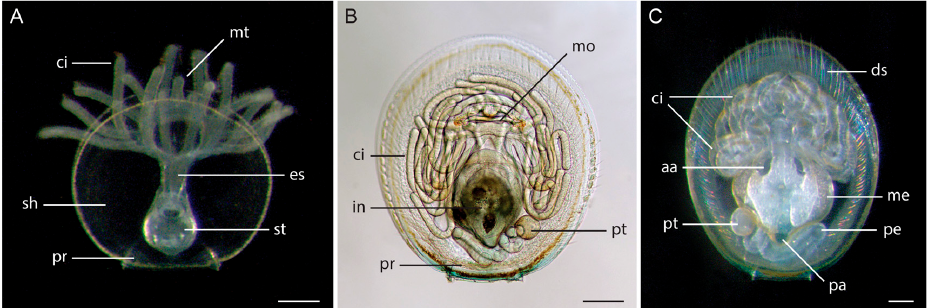
Figure 2. Larval Glottidia from Bocas del Toro. ( A ) Larval stage with eight pairs of cirri a defined protegulum, and no pedicle; ( B ) Larva with nine pairs of cirri, setae around the margin of the shell, and a well ‐ developed pedicle; ( C ) Larva with an elongate shell, setae extending from the anterior shell margin and a large pedicle. Abbreviations: aa, anterior adductor; ci, cirri; ds, definitive setae; es, esophagus; in, intestine; me, metacoel; mo, mouth; mt, median tentacle; pa, posterior adductor; p, pedicle; pr, protegulum; pt, pedicle tip; sh, shell; st, stomach. Scale bars = 100 μ m.